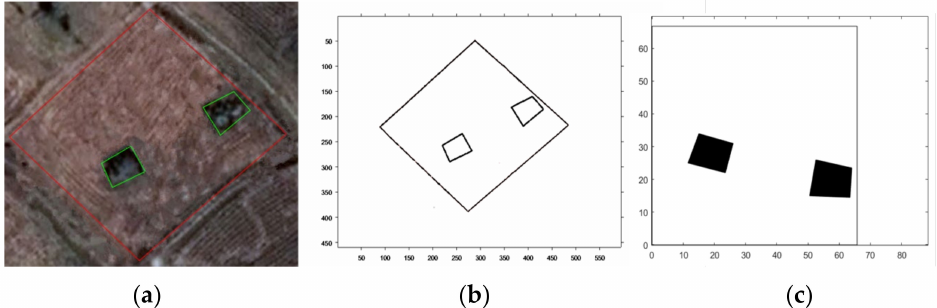
Figure 11. ( a ) Farmland map with obstacles; ( b ) map after binarization; ( c ) coordinate mapping to ( b ). Table 5. Geodetic coordinates of Figure 11a. Geodetic Coordinates of